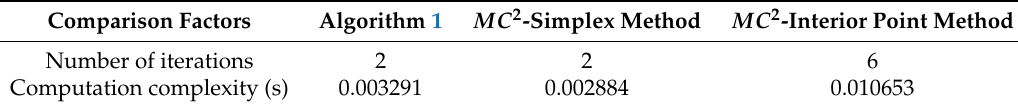
Table 6. Comparison study of the speed of three